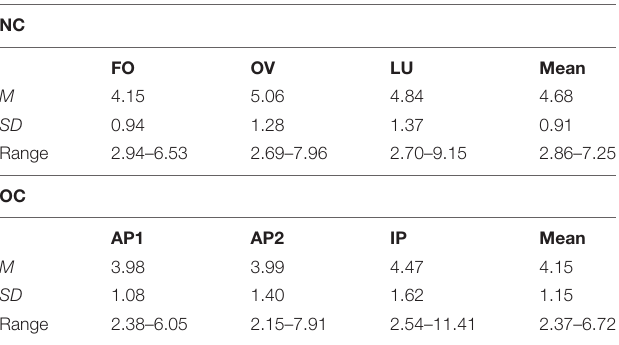
TABLE 2 | Mean (M), standard deviation (SD) and range of estradiol concentration in pg/ml across follicular (FO), ovulation (OV) and luteal phase (LU) in naturally cycling (NC) women and across active OC pill phase one (AP1), active OC pill phase two (AP2), and the inactive OC pill phase (lP) in oral contraceptive (OC) users.